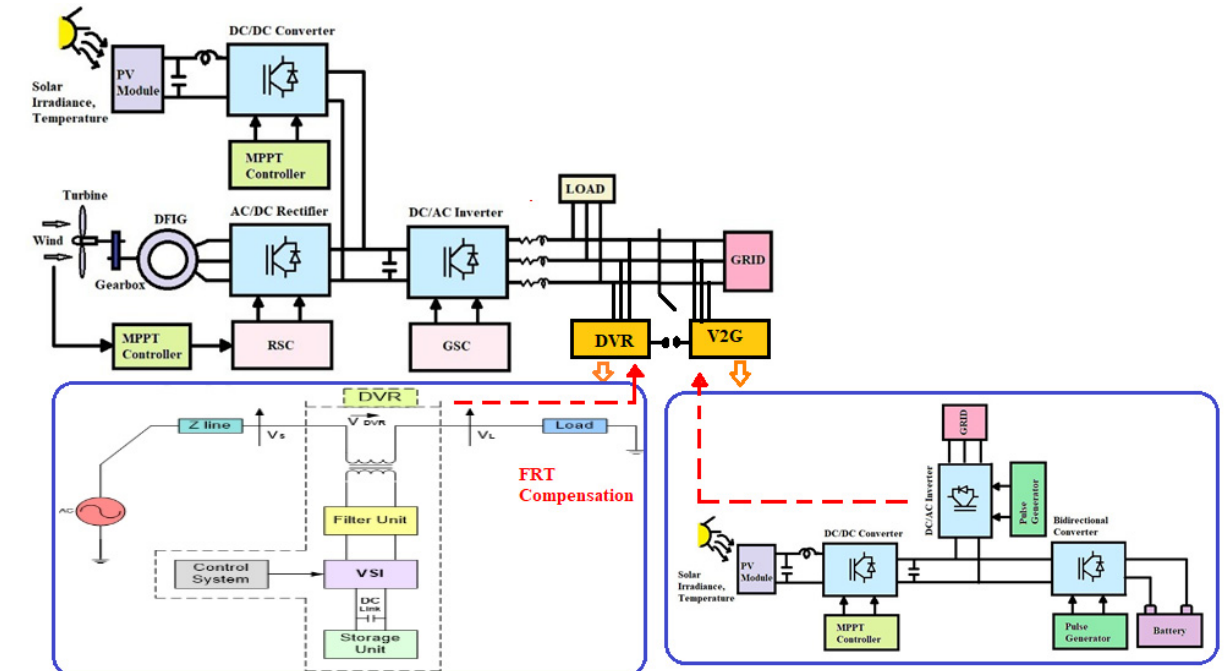
Figure 17. Fault ride through mode.